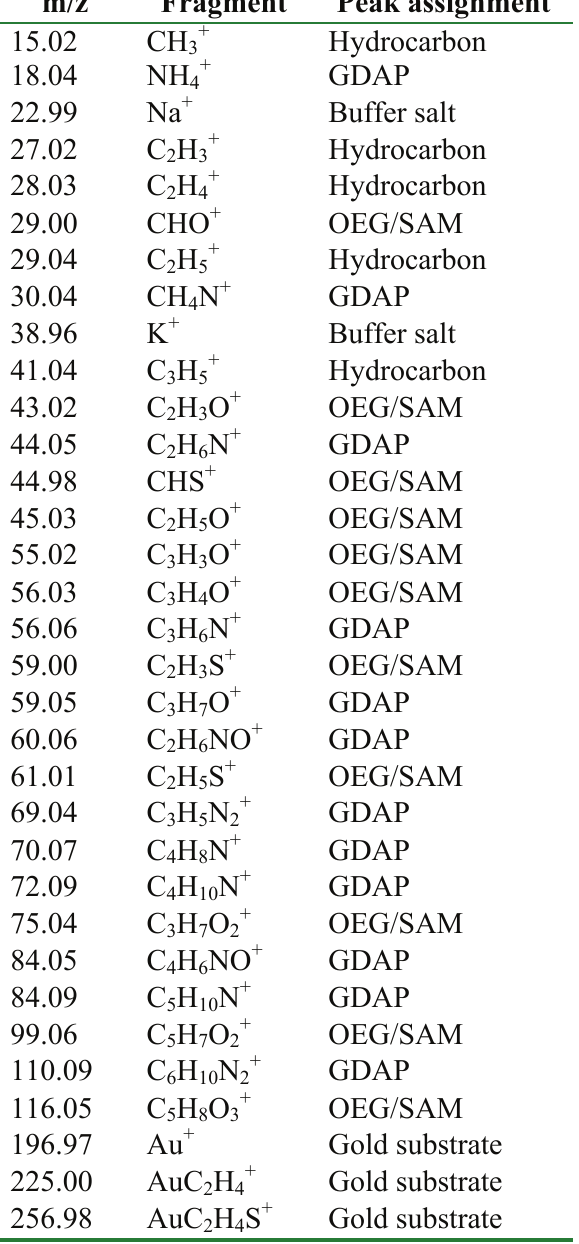
Table 1. Select peaks from PCA and their